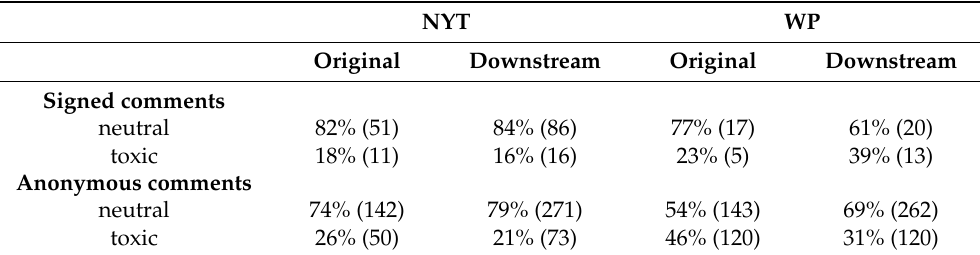
Figure 1. Cohen-Friendly graph of Table 1. Less toxic for signed comments. Figure 1. Cohen ‐ Friendly graph of Table 1. Less toxic for signed comments. Table 2. Proportions of toxic comments in New York Times and Washington Post. For both journals, anonymity is associated with more toxic